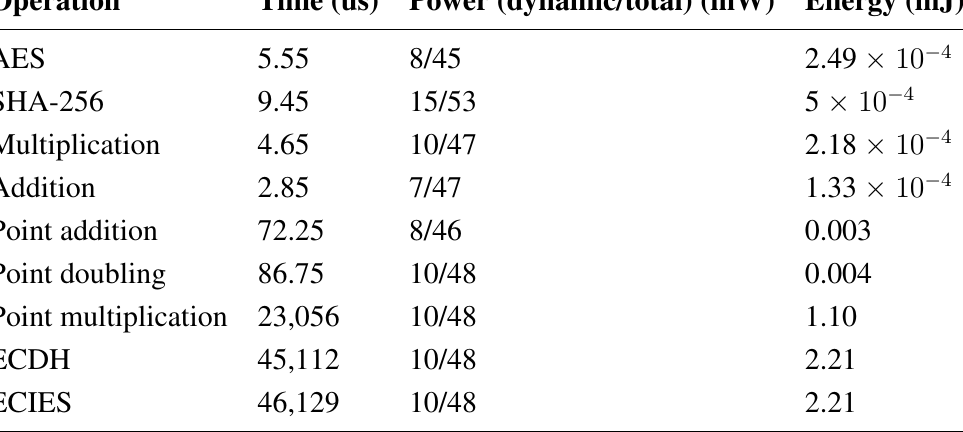
Table 7. Performance summary of the P-192 accelerator at 10 MHz. ECDH, Elliptic Curve Diffie-Hellman.